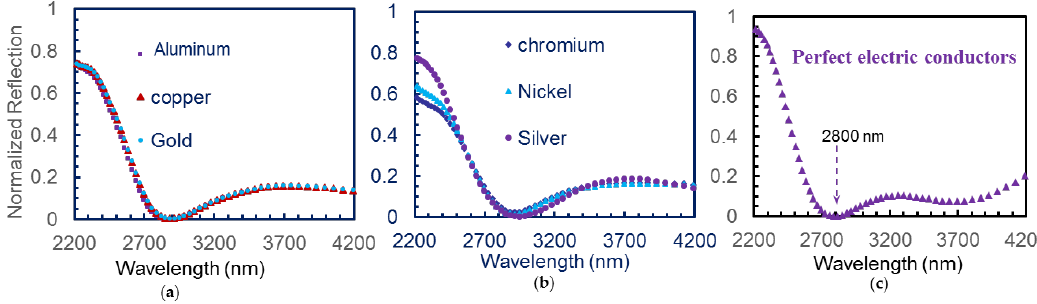
Figure 4. Simulations of the reflection spectrum of the patterned AZO, glass spacer and metal film stacks for a group of metals of aluminum, copper and gold ( a ); a group of metals of chromium, nickel and silver ( b ); and when the metal is replaced by perfect electric conductors ( c